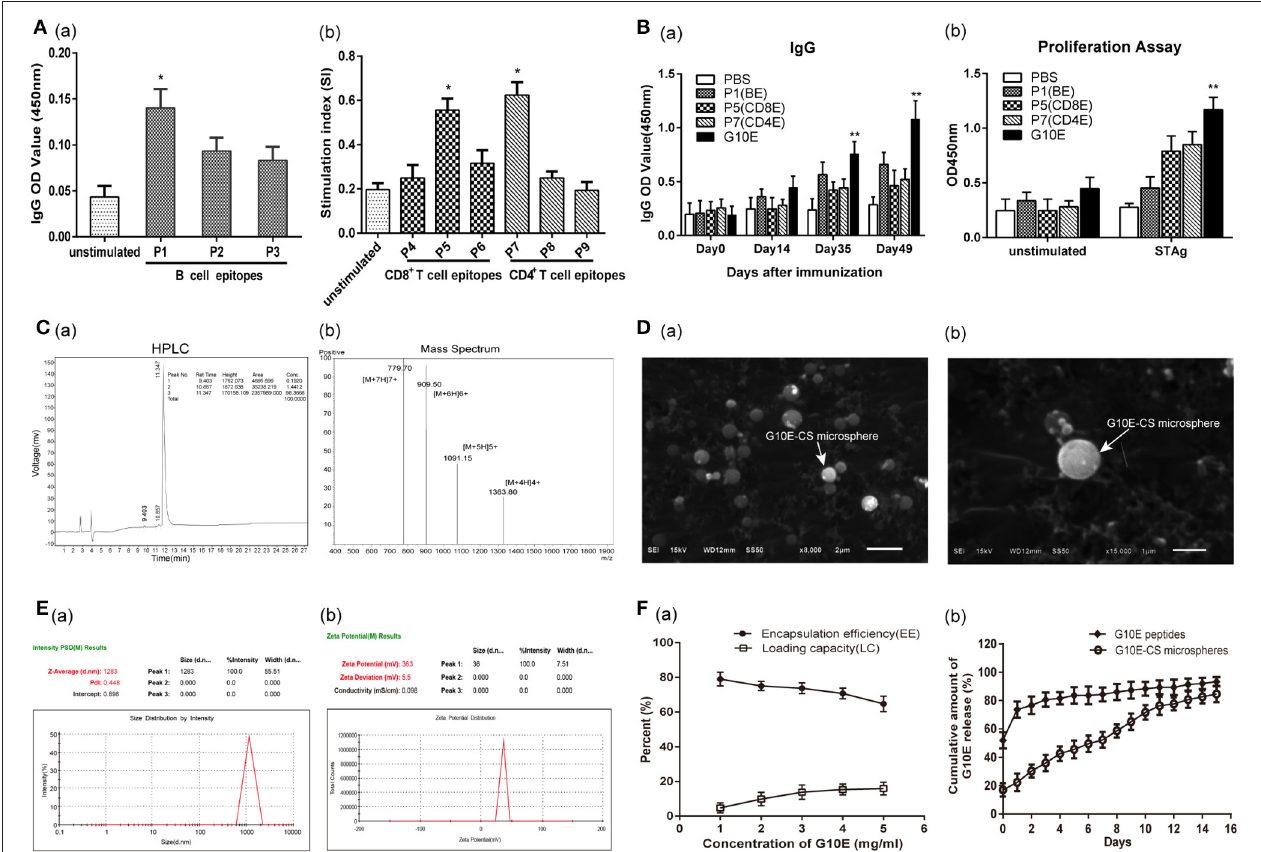
FIGURE 2 | Screening of dominant epitopes from GRA10 and characteristic of G10E-CS. (A) Screening of the dominant B cell epitopes (a) and T cell epitopes (b) from TgGRA10. Positive serum samples from T. gondii infected mice were used to screen dominant B cell epitopes by ELISA analysis. Lymphocyte proliferation test was used to identify dominant CD8 + T and CD4 + T cell epitopes from spleen cells of infected mice by CCK-8 assay. P1(TQSPPESRKKRRRSGKKKRGKRSV)(B cell epitope), P5(LGYCALLPL) (CD8 + T cell epitope) and P7(SGFSLSSGSGVSVVE) (CD4 + T cell epitope) were selected to construct the multiple antigenic peptide (MAP) of T. gondii GRA10 (G10E). Values represent mean ± SD ( n = 5). * p < 0.05. (B) Immunogenicity of P1, P5, P,7 and G10E peptides. Mice immunized with P1(B cell epitope), P5(CD4 + T cell epitope), P7(CD8 + T cell epitope) or G10E (P5-P7-P1) were tested for B cell antibody (a) and T cell proliferation ability (b) .** p < 0.01. (C) The purity of G10E peptides detected by high performance liquid chromatography (HPLC) (a) and the molecular weight of G10E peptides analyzed by electrospray ionization mass spectrometry (ESI-MS) (b) . (D) Scanning electron microscopy (SEM) images of G10E-CS microspheres prepared by emulsion crosslinking method. G10E-CS microspheres were then imaged at magnification of × 15,000 (bar represents 1 µ m). (E) The diameter (a) and zeta of G10E-CS (b) microparticles was detected by Malvern particle size potentiometer. (F) Loading capacity (%LC) and encapsulation efficiency (%EE) of G10E-CS microspheres amongst 1–5 mg/ml concentration of total G10E peptides (a) . Release profile of G10E peptides from free G10E peptides and crosslinked chitosan microparticles (G10E-CS) in vitro over a 15-day period (b) . The amount of G10E in the supernatant was measured using BCA assay. Values represent mean ± SD ( n = 3).